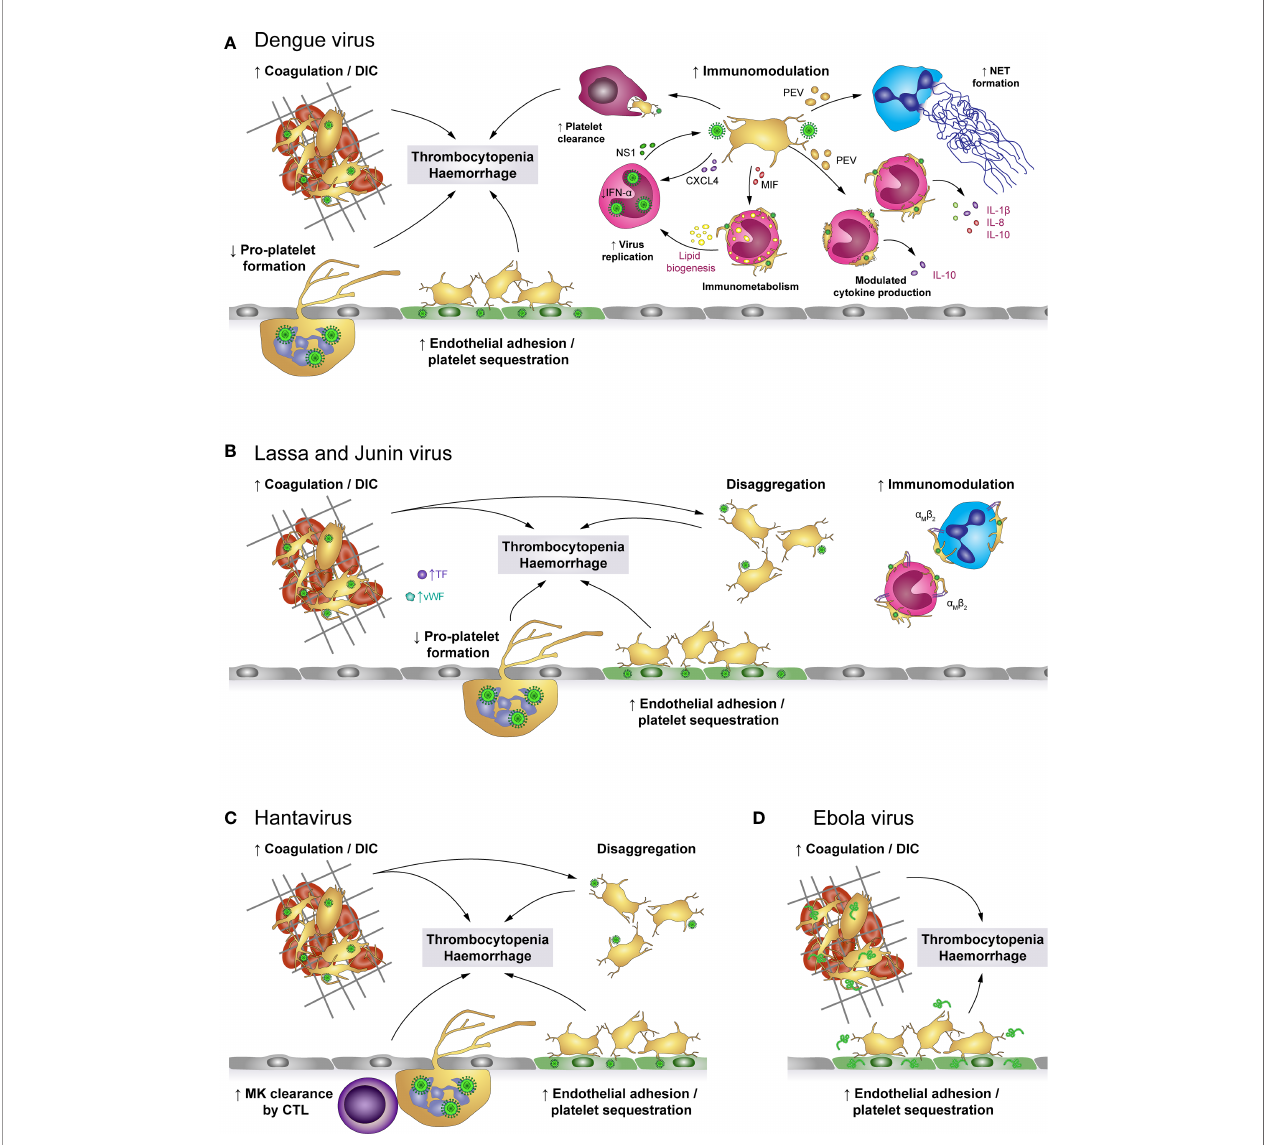
FIGURE 4 | The role of platelets in viral haemorrhagic fevers (VHF). (A) Dengue virus activates platelets and promotes the development of disseminated intravascular coagulation (DIC), leading to platelet consumption. Additionally, activated platelets adhere to infected endothelial cells and infected megakaryocytes (MK) show impaired pro-platelet formation. Together with macrophage-mediated clearance of virus-activated platelets, these mechanisms lead to thrombocytopenia and enhanced haemorrhagic complications. In addition, virus-stimulated platelets bind to leukocytes or release soluble factors to modulate immune responses such as NET formation as well as production of a speci fi c cytokine pro fi le, depending on whether interacting platelets are activated or apoptotic. Platelet-derived factors also promote virus replication in monocytes which is further fostered by modulated immunometabolism and platelet-induced lipid biogenesis. (B) Infection with Lassa or Junin virus is associated with elevated levels of von Willebrand factor (vWF) and tissue factor (TF) which contribute to platelet activation and development of DIC. While activated platelets readily bind to monocytes and neutrophils via their a M b 2 receptor, they are unable to maintain stable platelet-platelet interaction and rapidly disaggregate. Further, virus infection augments endothelial platelet adhesion and sequestration and limits pro-platelet formation of MKs. Thereby, infection with Lassa or Junin virus leads to thrombocytopenia and increases bleeding risk. (C) Hantavirus readily infects endothelial cells which promotes endothelial platelet adhesion and sequestration from the circulation. While infected megakaryocytes display no differentiation dysfunction, they are cleared by cytotoxic T lymphocytes (CTL). Systemic infection triggers a pro-coagulatory state which may exacerbate to DIC. Nevertheless, platelets show impaired capacity to form stable aggregates. Hantavirus thus causes thrombocytopenia and haemorrhagic complications by affecting key mediators of haemostasis. (D) Infection with Ebola virus is associated with systemic coagulation induction and risk for DIC, which leads to platelet consumption. However, platelets may also be sequestrated due to enhanced adhesion to the infected endothelium. Thereby, Ebola virus causes thrombocytopenia and haemorrhagic complications. CTL, Cytotoxic T cell; CXCL4, chemokine (C-X-C motif) ligand 4; DIC, Disseminated intravascular coagulation; IFN- a : Interferon a ; IL, Interleukin; MIF, Macrophage migration inhibitory factor; MK, Megakaryocytes; NET, Neutrophil extracellular trap; NS1, Non-structural protein 1; PEV, Platelet-derived extracellular vesicle; TF, Tissue factor; VHF, Viral haemorrhagic fevers; vWF, von Willebrand